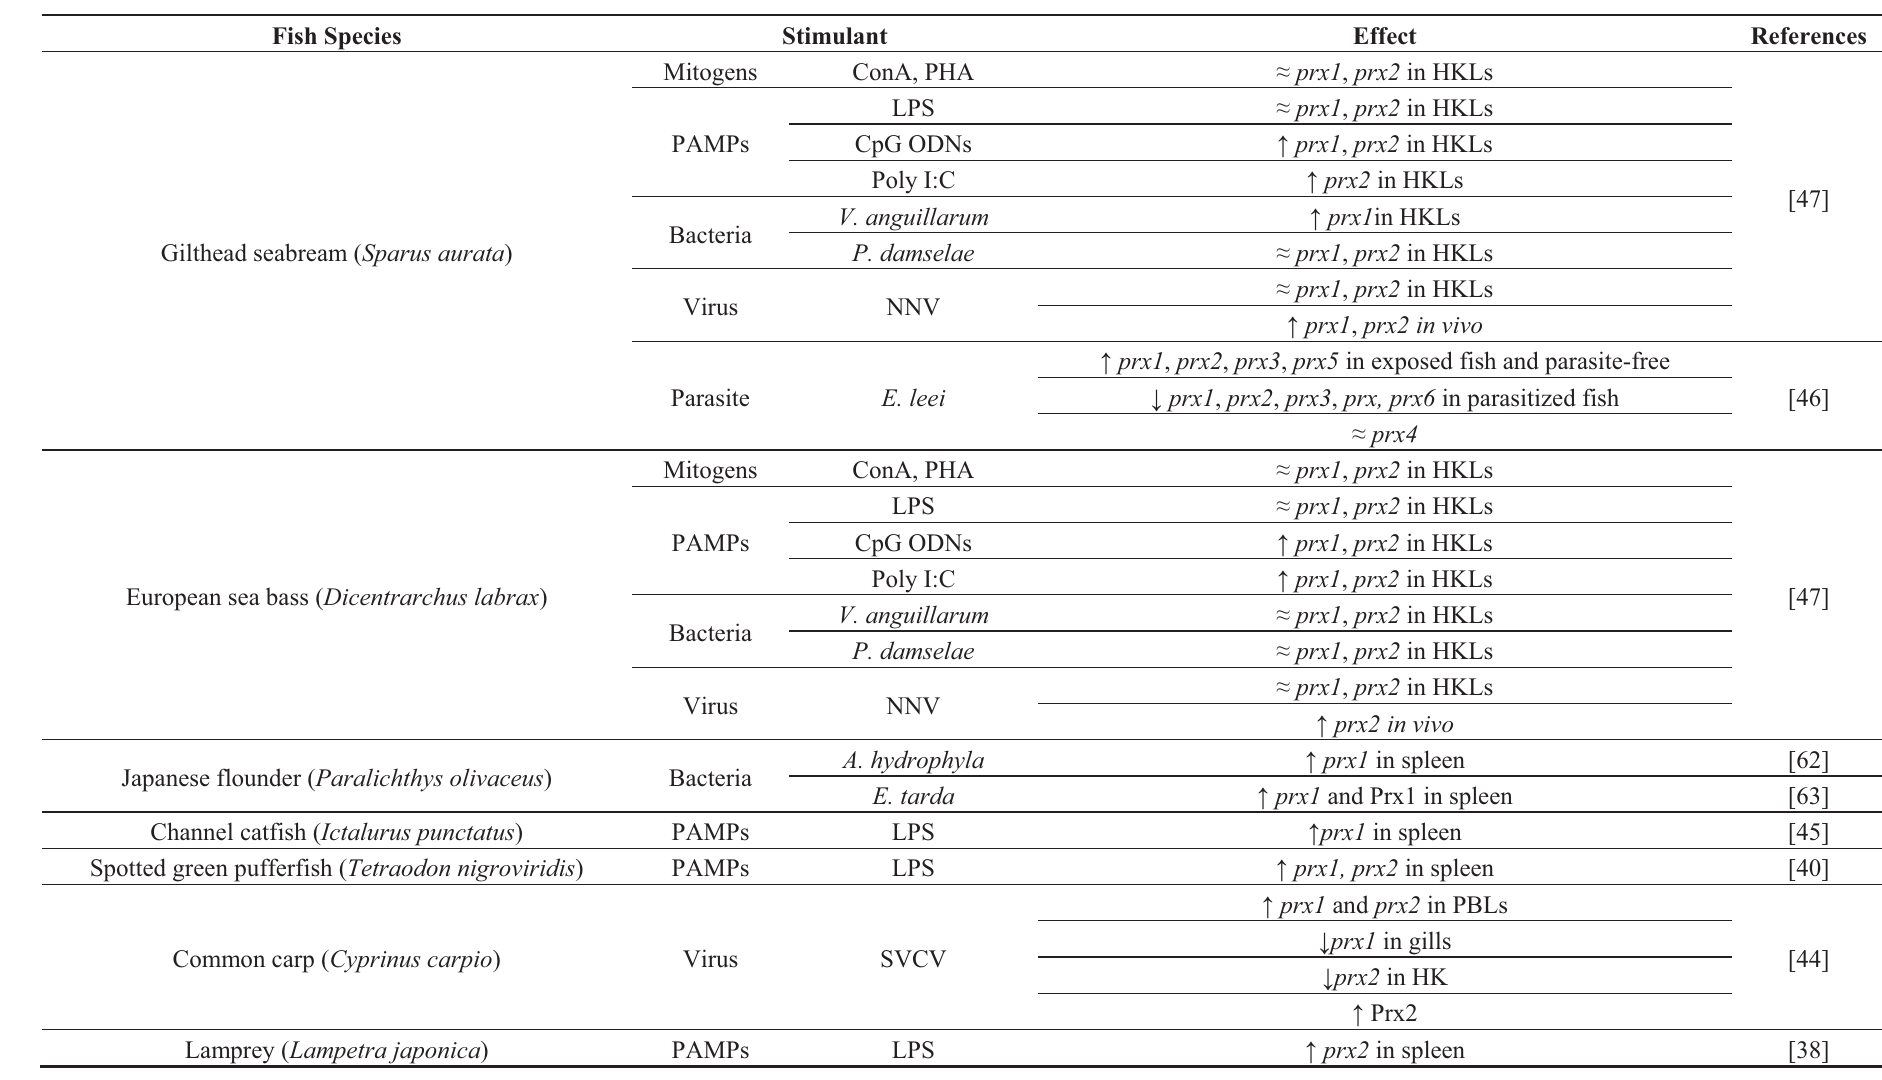
Table 1. Summary of the studies showing the regulation of peroxiredoxin genes ( prx ) or protein (Prx) expression after common immune stimuli in